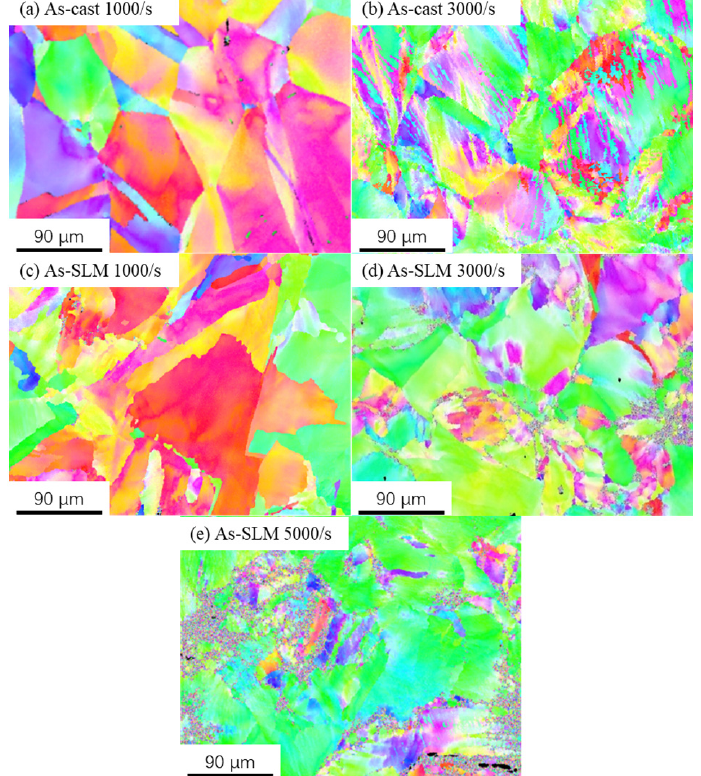
Figure 4. EBSD IPF maps of the deformed specimens. ( a ) a few tiny deformation twins in the 1000/s